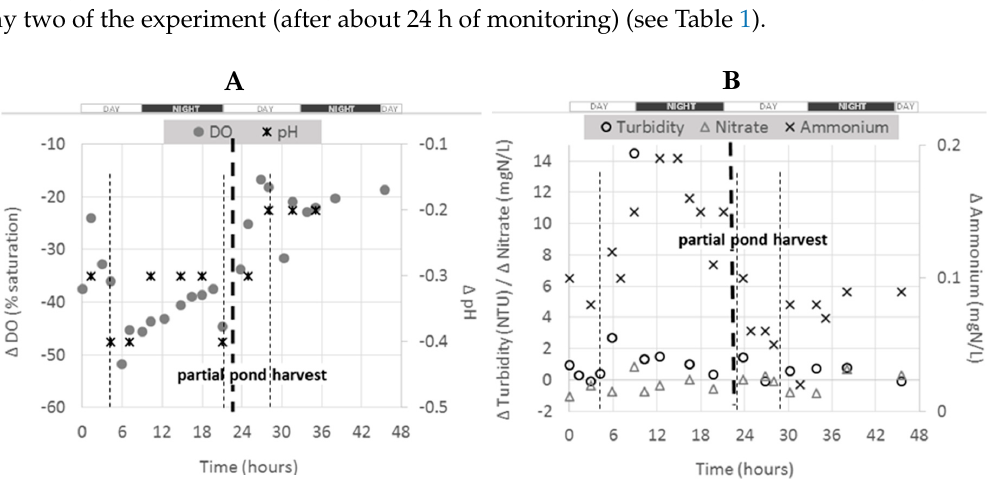
Figure 4. Pond 1 13 differential values between outlet and inlet for dissolved oxygen and pH ( A ) and for turbidity, nitrate and ammonium ( B ) during the monitoring program. Vertical light dash lines represent feeding times.